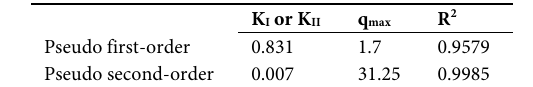
Table 1, Kinetic parameters of pseudo-first-order and pseudo-second-order kinetic K I or K II q max R 2